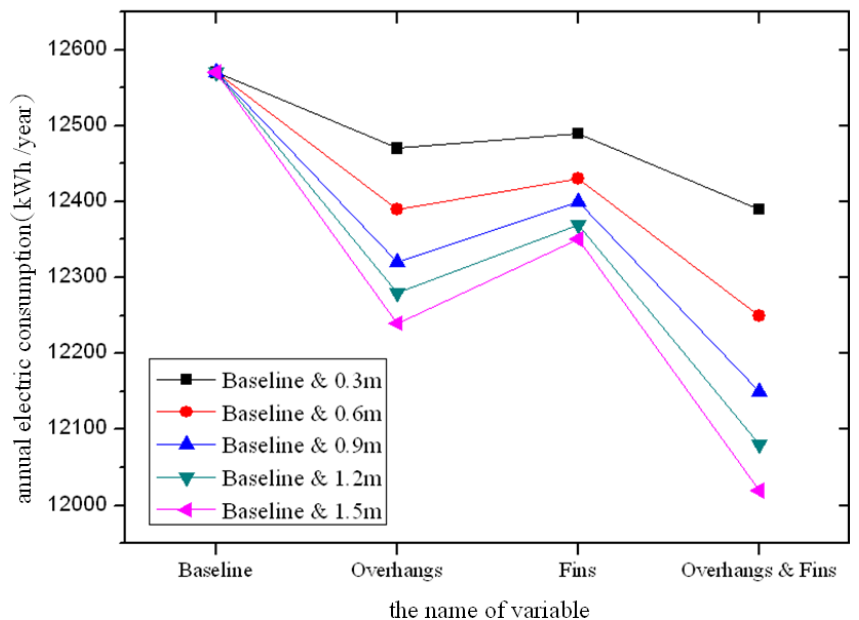
Figure 8. Comparison of annual energy consumption between the baseline and various shading